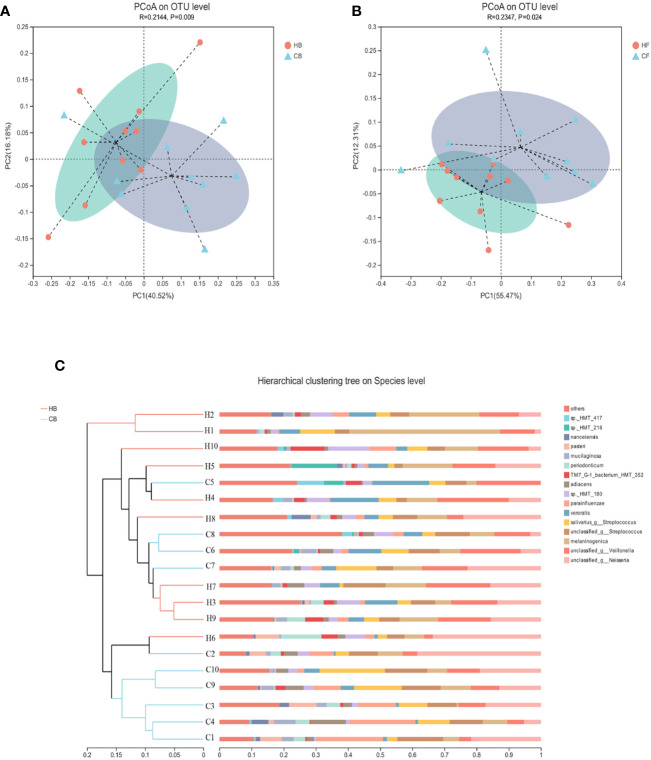
The inter-individual variations of the microbiome community structure. (A, B) The PCoA based on the weighted normalized UniFrac distance present the intel-individual variations of the tongue coating microbiota in the different groups. (C) The hierarchical clustering analysis (HCA) based on the weighted normalized UniFrac distance for baseline samples.